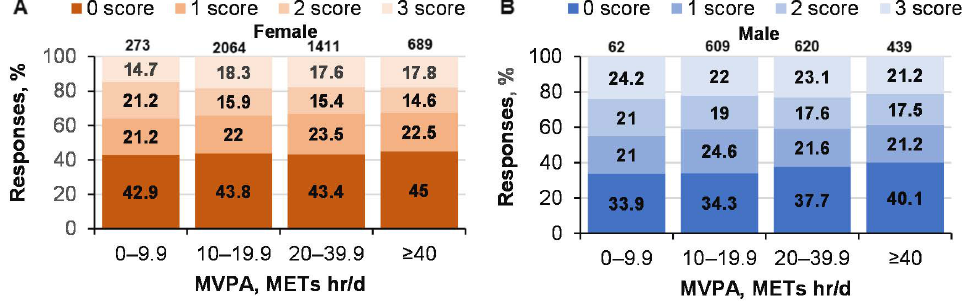
Figure 4. Solving CRT tasks in men and women of different ages with MVPA METs. (( A )—women CRT responses % and MVPA; ( B )—men CRT responses % and MVPA).